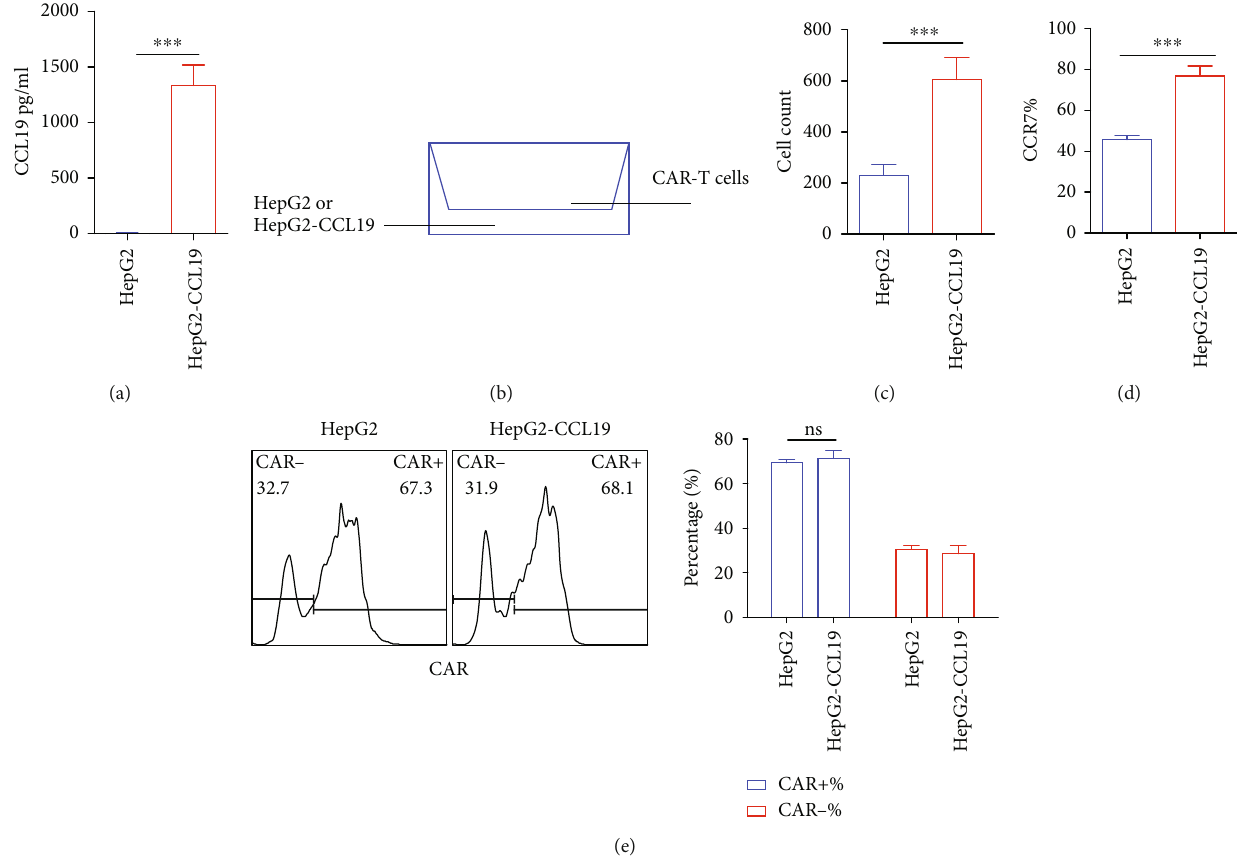
Figure 2: In vitro chemotaxis of CAR-T by CCL19. (a) Detection of CCL19 expression levels of HepG2 and HepG2-CCL19 by ELISA; (b) schematic diagram of the principle of chemotaxis experiment; (c) analysis of HepG2 and HepG2-CCL19 on CAR-T chemotaxis; (d) cell phenotype; (e) positive rate of CAR. Error bars represent mean ± SD ( n = 3 ); ns: no signi fi cant di ff erence ∗∗ P < 0 : 01 ; ∗∗∗ P < 0 : 001 .